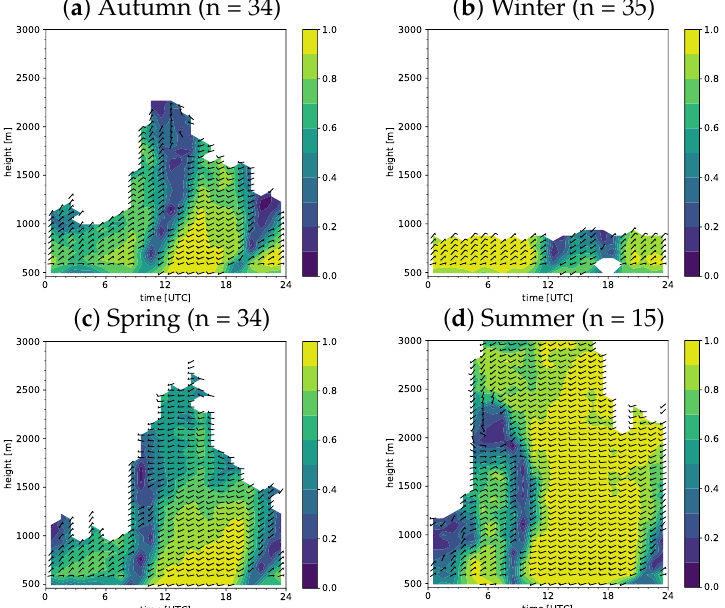
Figure A1. As in Figure 7 for directional consistency